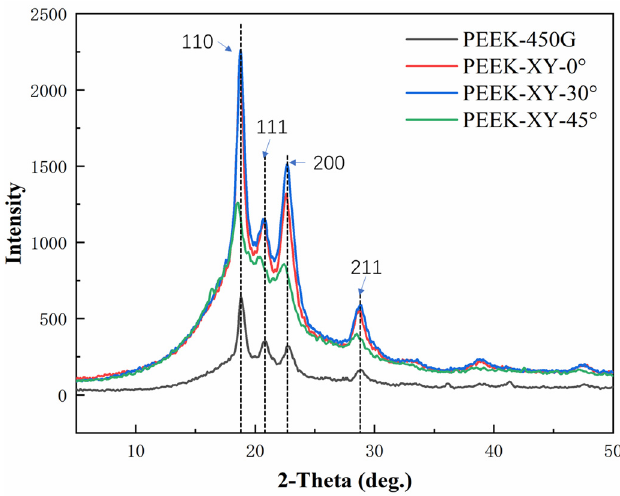
Figure 3. XRD scans of PEEK 450G and FDM printed PEEK parts.